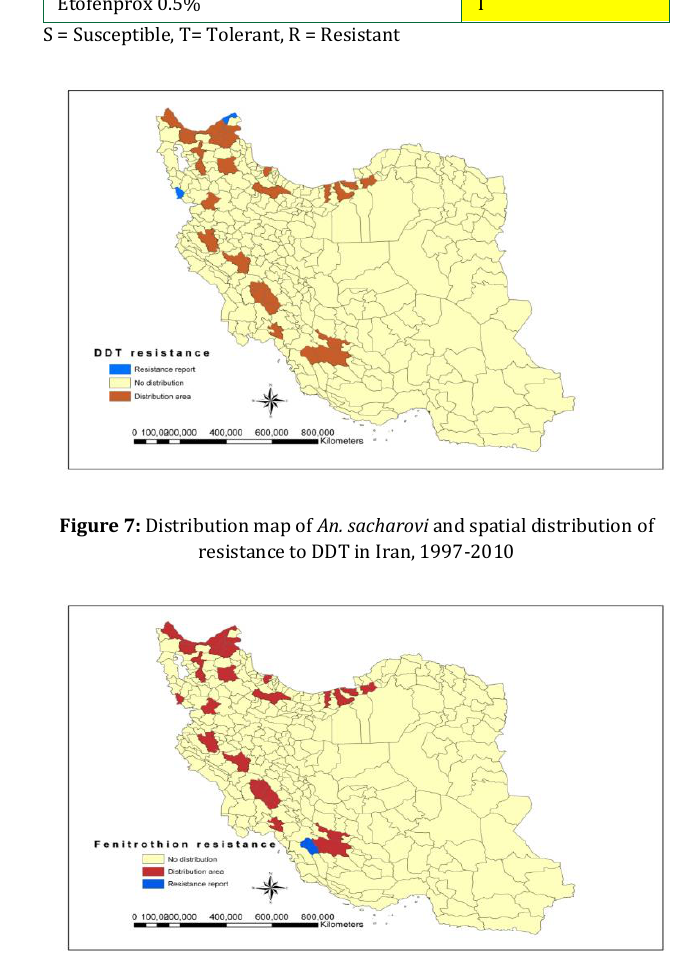
Figure 8: Distribution map of An. sacharovi and spatial distribution of resistance to Fenitrothion in Iran,